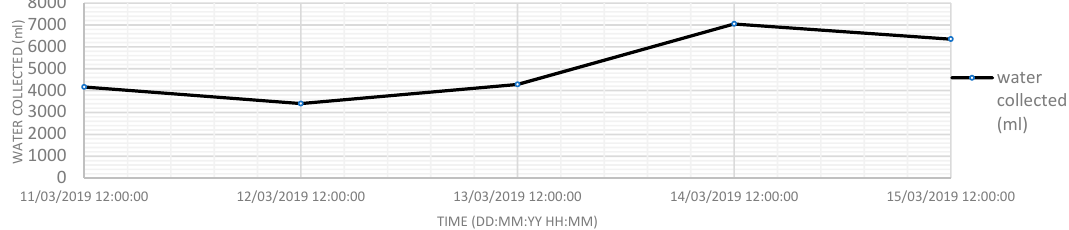
Figure 15. Total collected water from SS and humidification-dehumidification (HDH) in the second week.